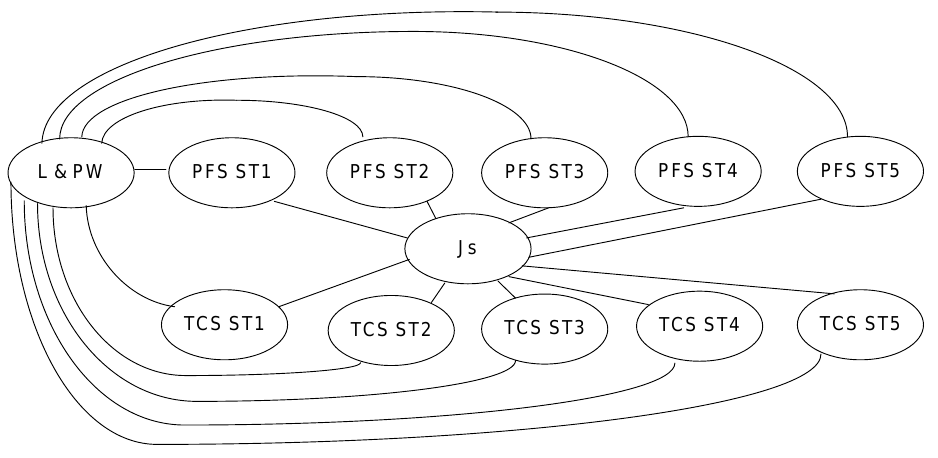
Figure 6. “Conceptual interface schema between modules”. Source: authors